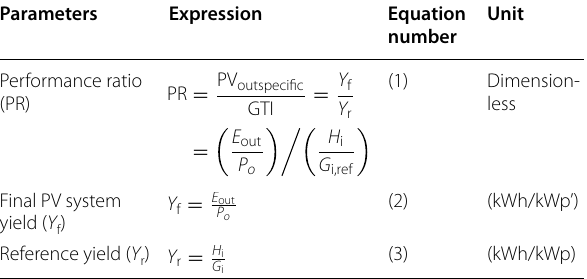
Table 4 Expressions linking PR (Atsu et al. 2021; Bansal et al. 2021; Shrivastava et al.